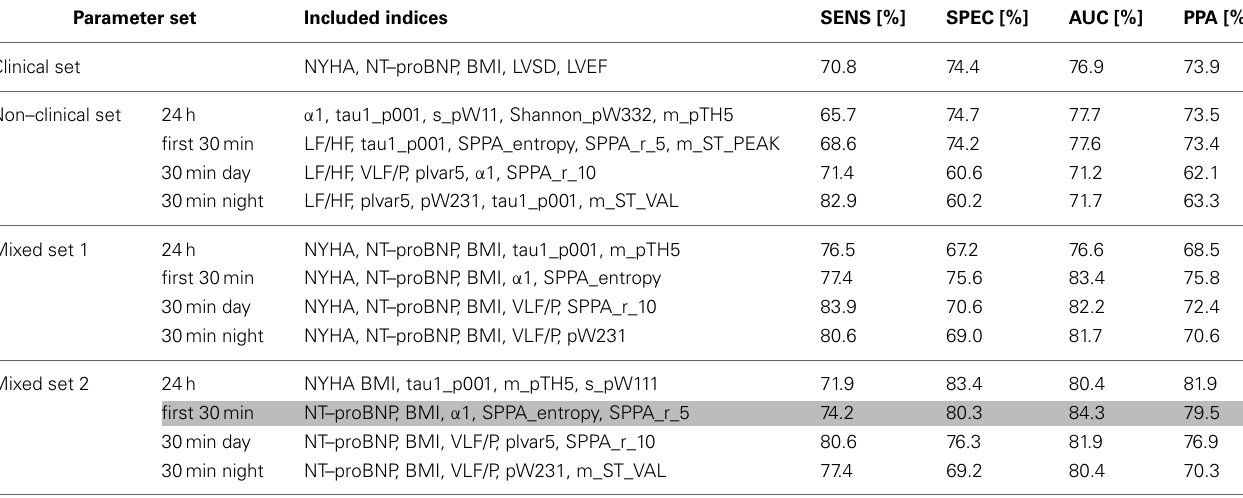
Table 6 | Multivariate classification results (discriminant analysis) of a clinical parameter set and 3 × 4 different optimal parameter sets (one non–clinical set, two mixed sets estimated for each 24h, first 30min, and 30min most stationary day and night beat–to–beat time series) consisting each of five